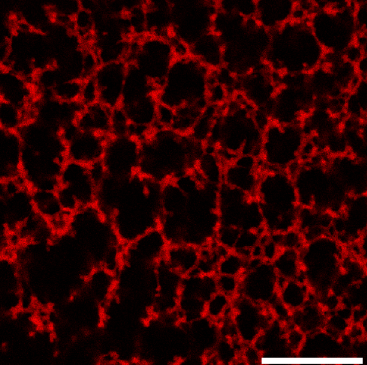
Figure 2. Confocal microscopy image of a viscoelastic solution of 1a at a concentration of 1 wt % under neutral conditions. The scale bar corresponds to 50 μ